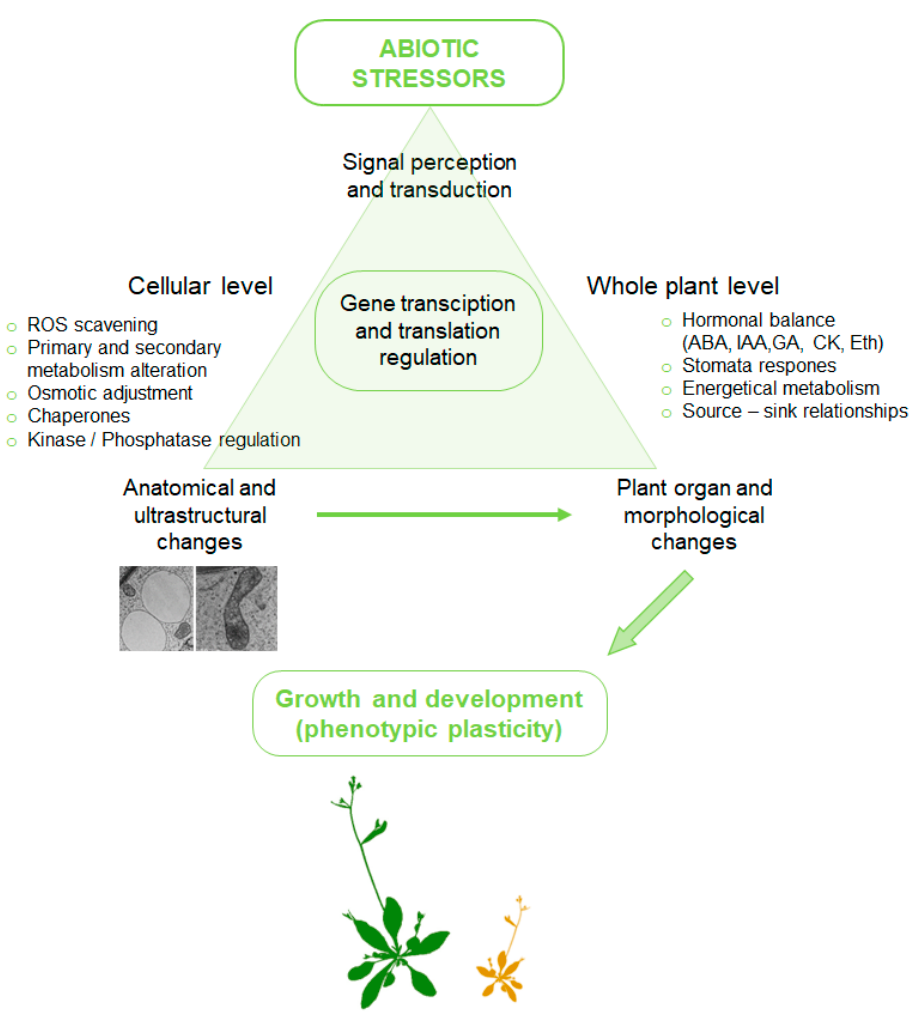
Figure 3. Hierarchic concept of plant phenotype modifications under abiotic stress. Stress caused by abiotic environmental factors induces, on one hand, whole-plant changes that result in plant organ and morphology abnormalities, and on the other hand, plant alterations at the cellular level resulting in anatomic and ultrastructural modifications. These changes arise from signal transduction discrepancies and/or impairments in the regulation of gene expression, and often result in growth and development retardation or death of the plant